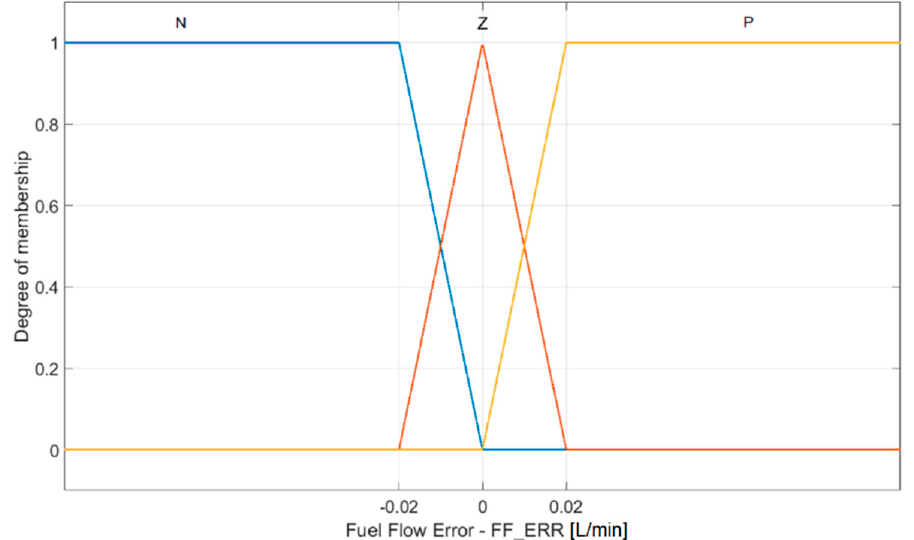
Table 1. The values of the output variables of the TSK controller.